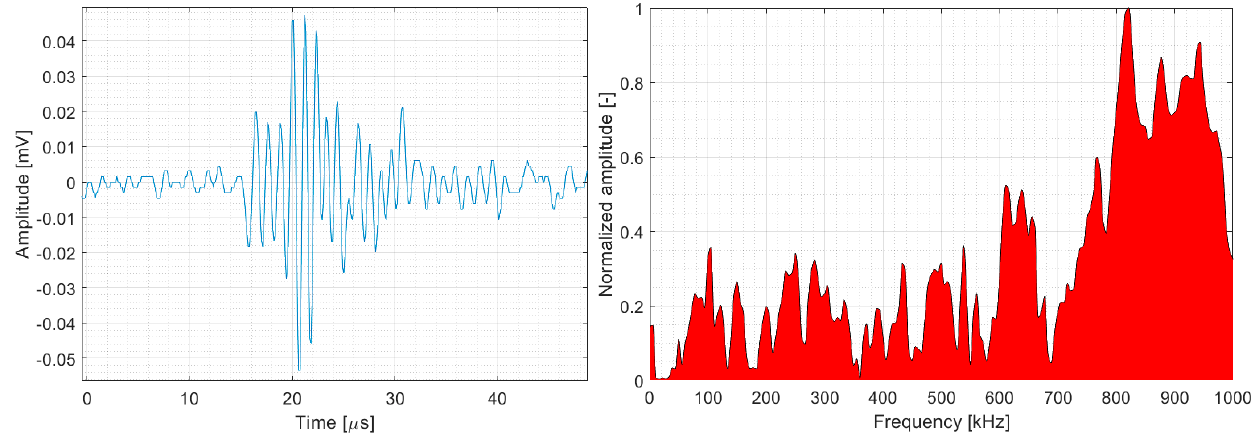
Figure 30. Representative AE signal of fibre pull-out (DWC 454 dataset).